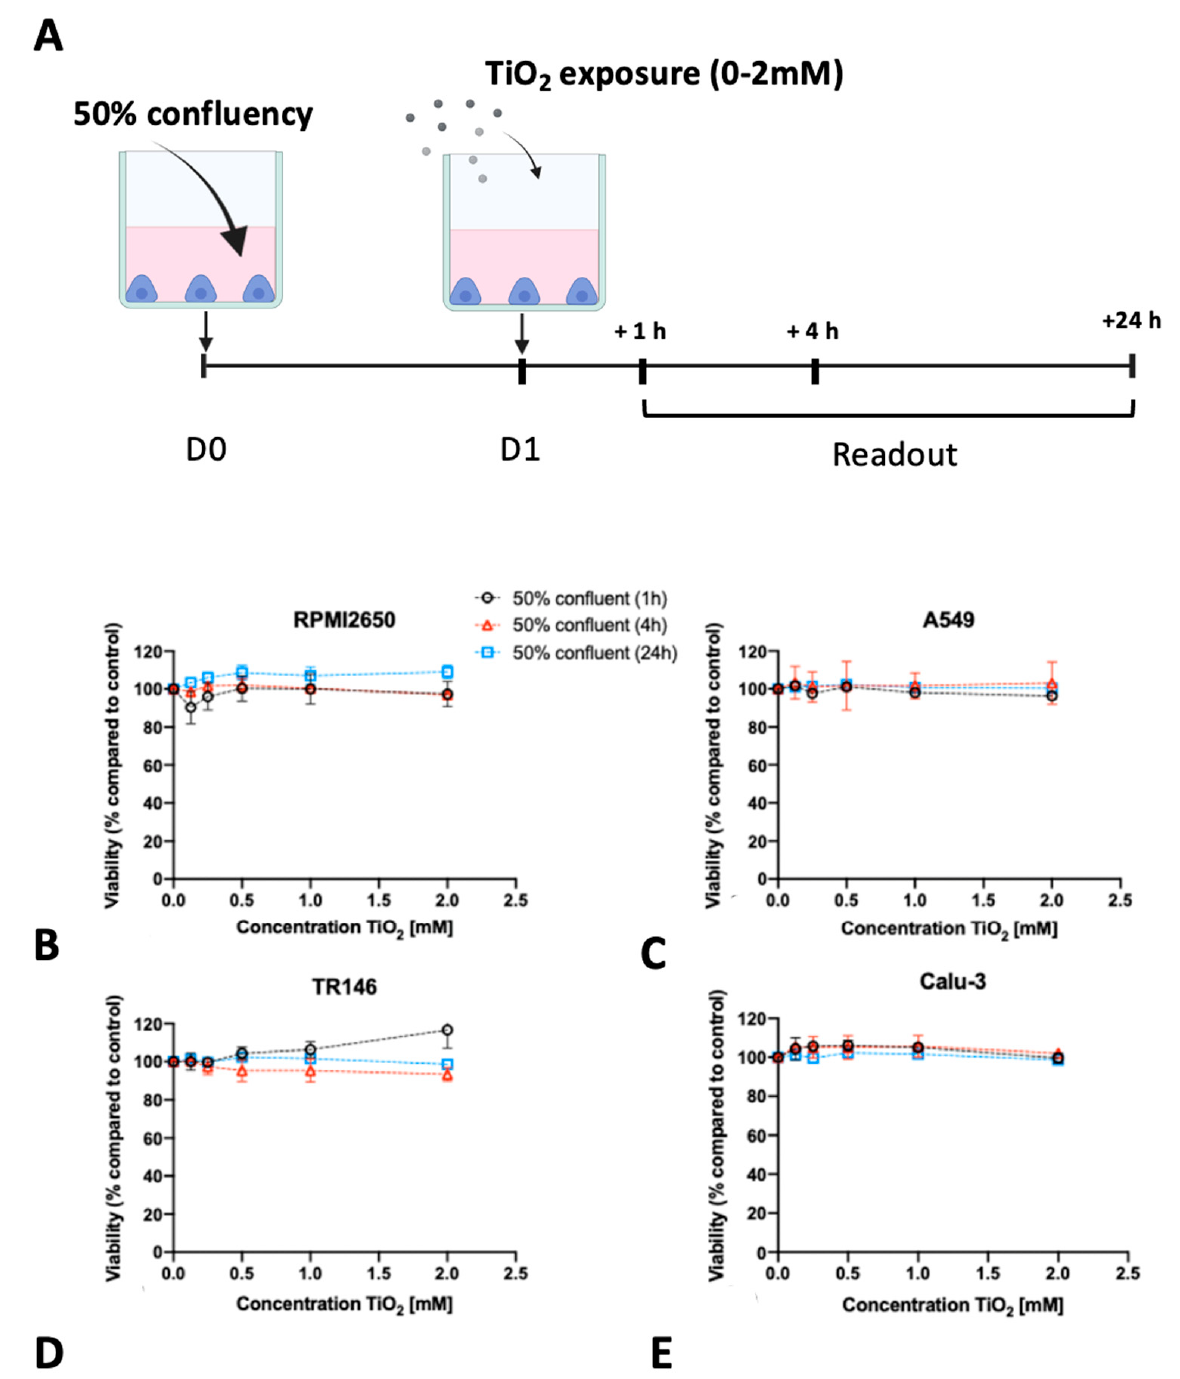
Figure 5. ( A ) Visual representation of the assay protocol for investigating the impact of 50% initial seeding density on nanotoxicological readout using Presto Blue viability assay. ( B – E ) TiO 2 nanoparticle toxicity in submerged cultures at 50% confluency, 24 h post-seeding. Cell viability was measured using a Presto Blue assay at 1, 4, and 24 h post-exposure to 5–6 nm sized, uncoated TiO 2 -NPs, graphical timeline in ( A ). ( B ) RPMI2650, ( C ) A549 ( D ) TR146 and ( E ) Calu-3. Data are expressed as mean ± standard deviation for n = 3 replicates.